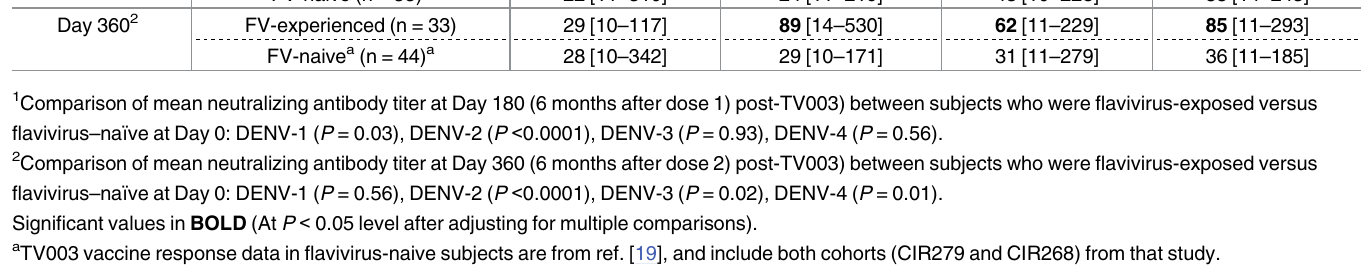
Table 4. Reciprocal mean neutralizing antibody titers 6 months after dose 1 (Day 180) and dose 2 (Day 360) after vaccination with TV003 of sub- jects who were either flavivirus-experienced or–na ï ve a at time of first vaccination.